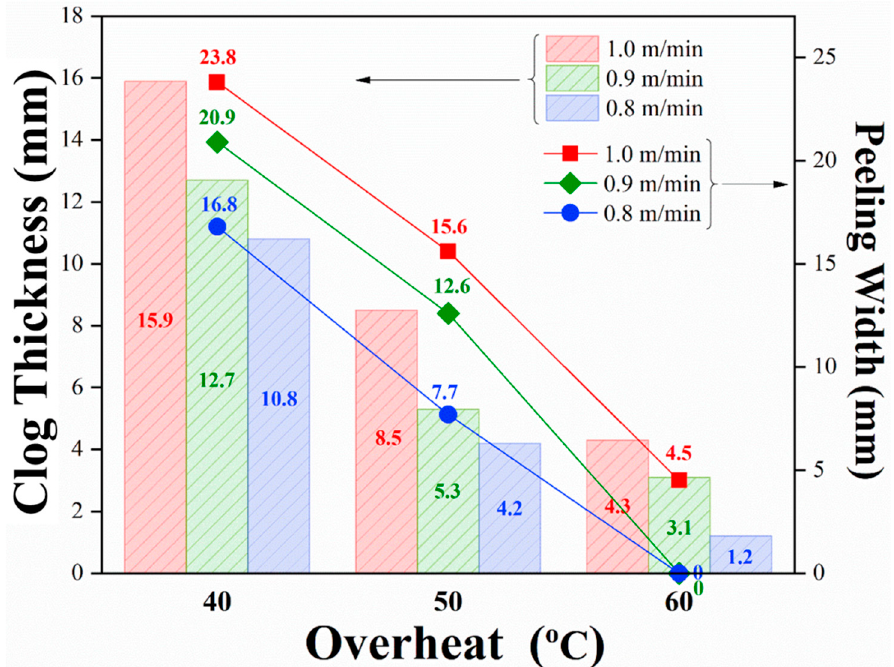
Figure 10. Relationship between peeling defect size and process